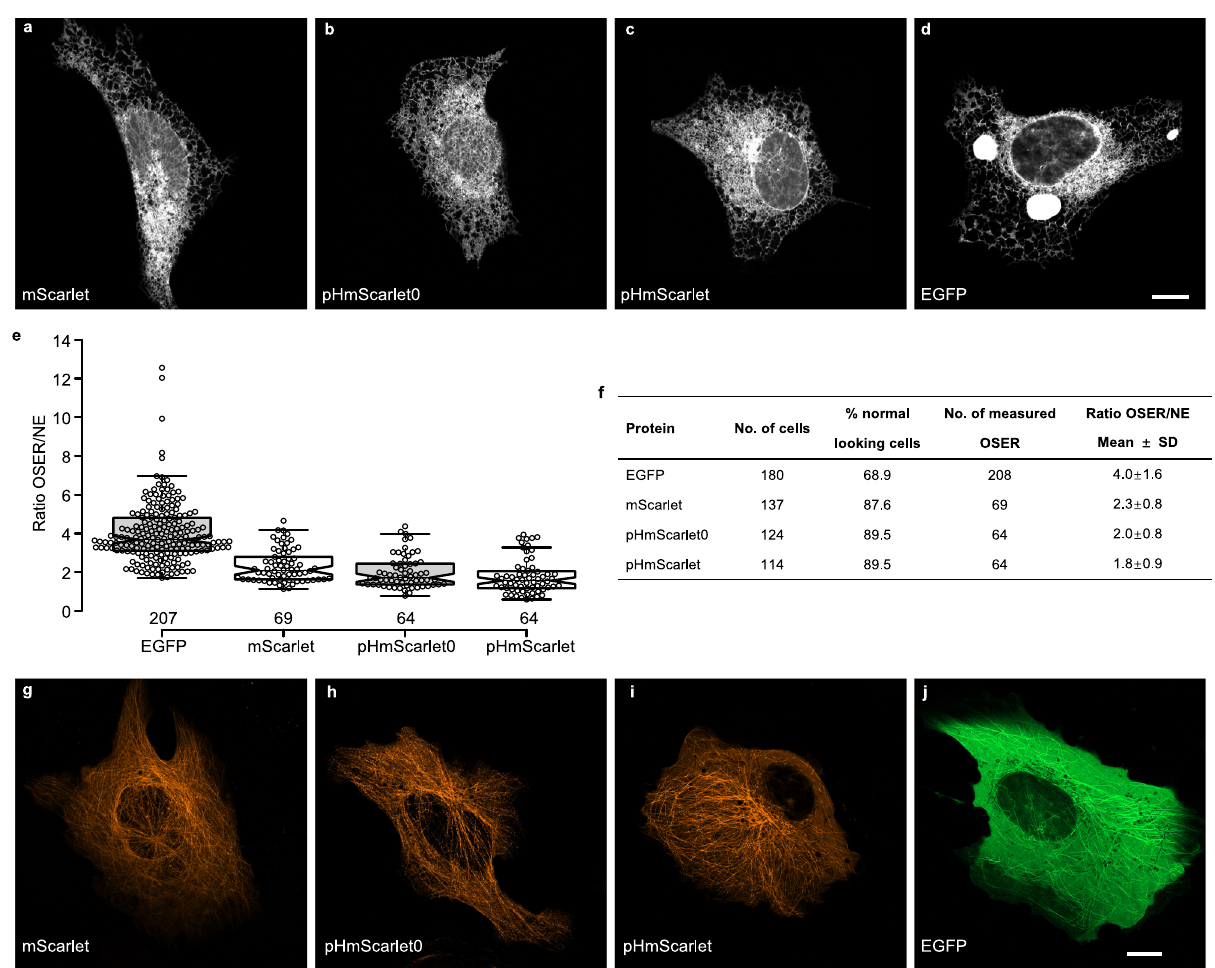
Fig. 3 Assessment of monomeric properties of FPs in U-2 OS cells. a – d OSER assay of U-2 OS cells transfected with plasmids encoding CytERM-FPs: a mScarlet, b pHmScarlet0, c pHmScarlet, and d EGFP. Scale bar is 10 μ m. e Ratio of the averaged intensity of the OSER over the mean intensity of the NE. Each dot represents an OSER structure. The median, upper whisker, and lower whisker are 3.68, 6.96, and 1.70 for EGFP, 2.10, 4.17, and 1.13 for mScarlet, 1.71, 3.97, and 0.78 for pHmScarlet0, and 1.56, 3.27, and 0.58 for pHmScarlet, respectively. f Table displaying the results of the OSER assay. ‘ Normal looking cells ’ are cells without OSER structures and without incorrect localization. g – j Microtubule structures in U-2 OS cells transfected with FP-7aa- α - tubulin: g mScarlet- α -tubulin, h pHmScarlet0- α -tubulin, i pHmScarlet- α -tubulin, and j EGFP- α -tubulin. Experiments were repeated two times for each FP. Scale bar is 10 μ m. Source data is provided as a source data fi